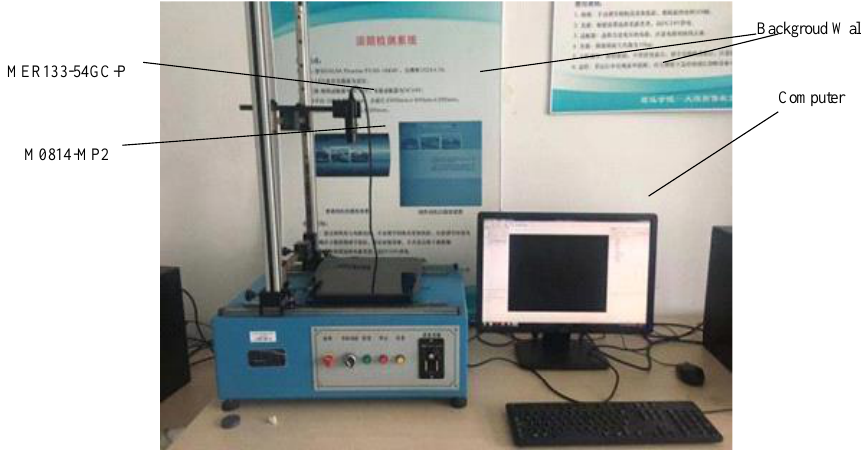
Figure 3. DAHENG experimental platform.